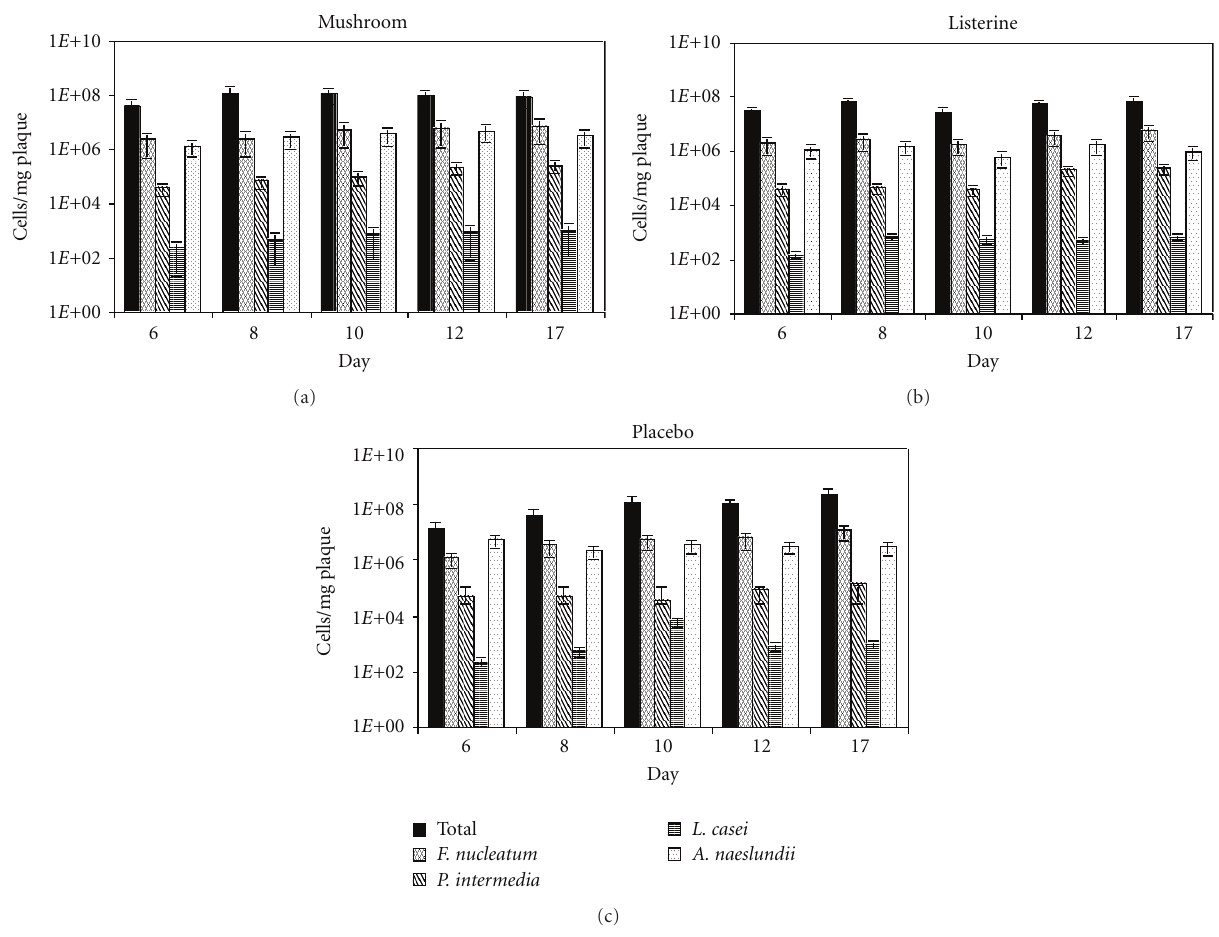
Figure 2: Numbers of each of the investigated taxa associated with gingivitis and total counts in dental plaque samples of the three cohorts enrolled in the study. Standard error bars represent the standard deviation ( n =